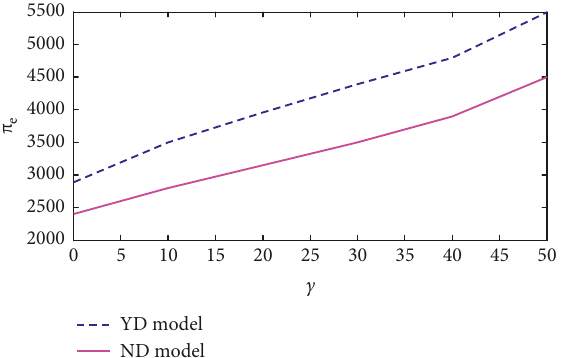
Figure 5: The impact of c on the e-commerce platform’s profit under the ND model and YD model.